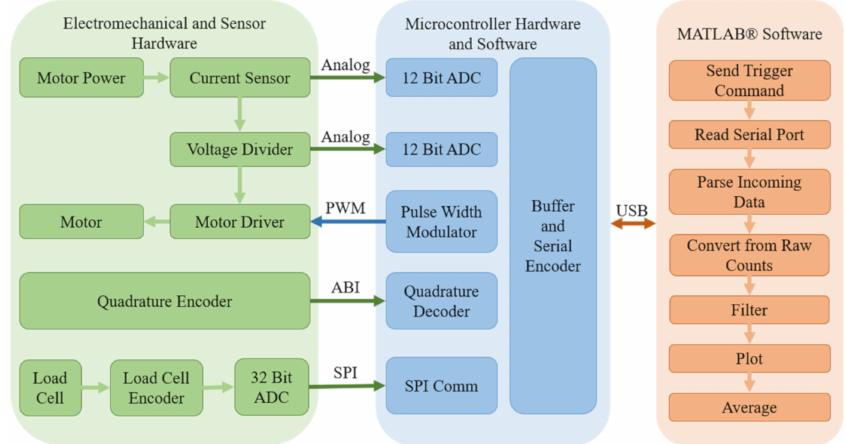
Figure 5. Complete system diagram. The system is comprised of three subsystems: electromechanical and sensor hardware, microcontroller hardware and software, and MATLAB ® software. Two analog signals and four digital signals are used to communicate between subsystems. Pulse width modulation (PWM), ABI quadrature encoder, serial peripheral interface (SPI), and universal serial bus (USB) are the four digital communication protocols